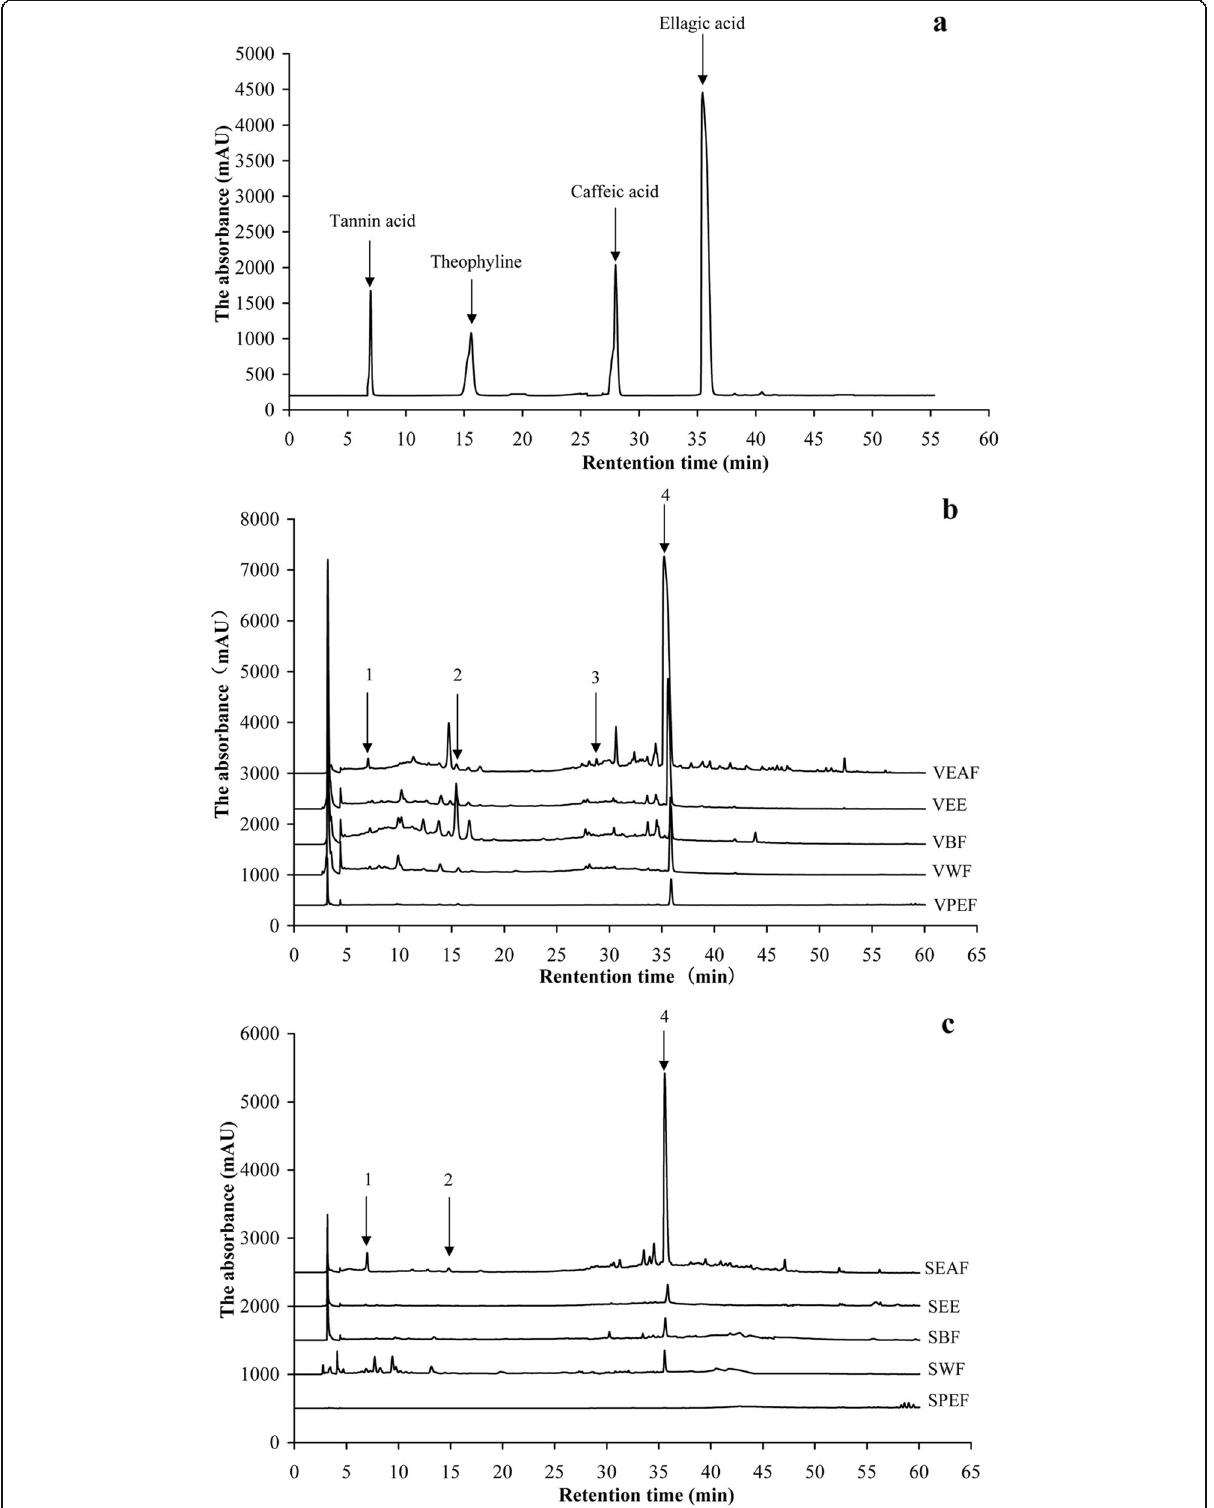
Fig. 1 Analytical HPLC chromatogram of reference substances ( a ) and compounds of extracts of valonia ( b ) and shell ( c ) from Q.